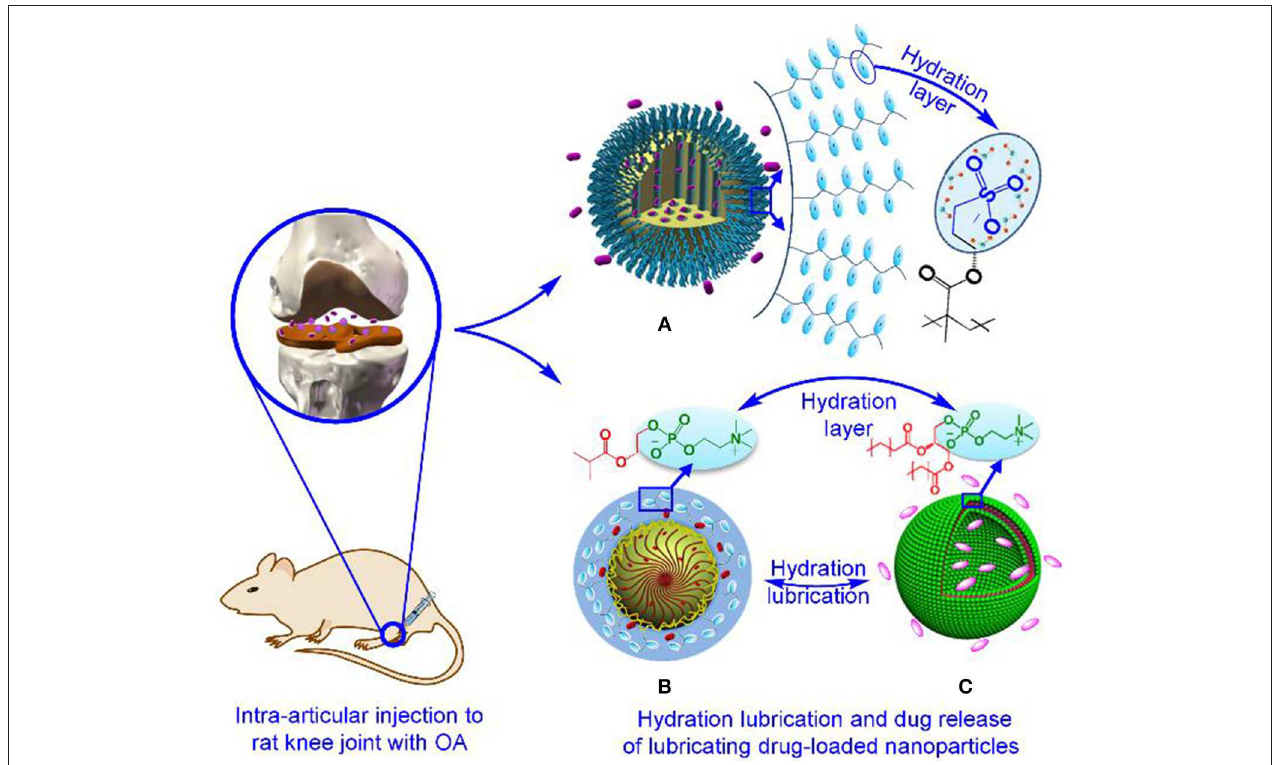
FIGURE 2 | Construction of typical intra-articularly injectable lubricating drug-loaded nanoparticles for OA treatment. Such dual-functional nanoparticles include (A) polymer brush-grafted MSNs with encapsulation of drugs (Yan et al., 2019), Copyright 2018, Wiley-Vch Verlag GmbH and Co. KGaA, Weinheim. (B) Self-lubricating polymer-based nanospheres encapsulated with drugs, and (C) drug-loaded liposomes ( Ji et al., 2019), Copyright 2019, the Royal Society of